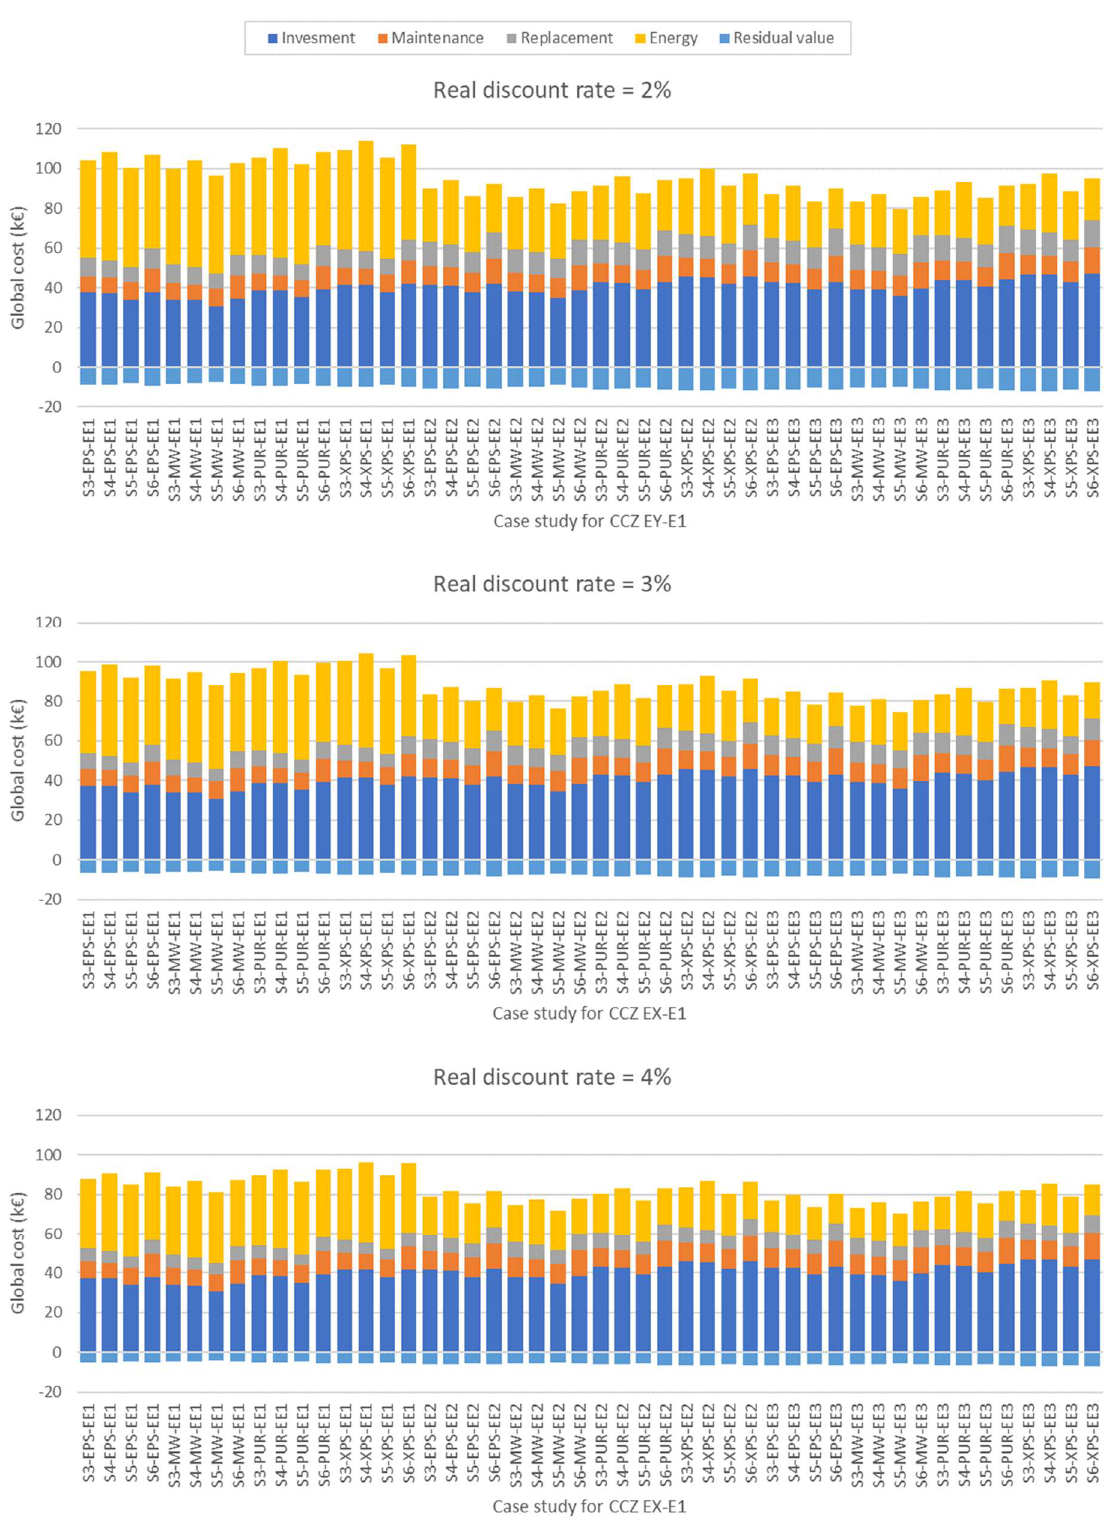
Figure 7. Global cost breakdown by the different costs and residual value, in EUR 1000, for each energy renovation solution in CCZ EX-E1 by real discount rate.